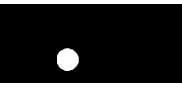
Figure 13. Binary image after the morphological